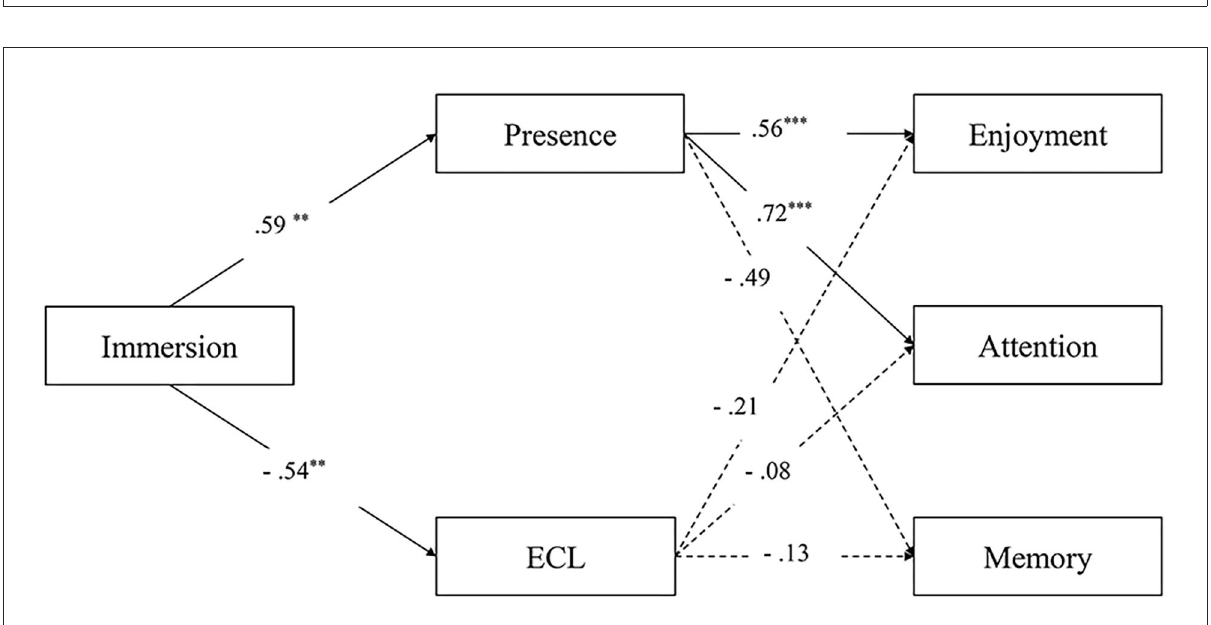
FIGURE2 Mediation models. * = p < .05. ** = p < .01. *** = p <